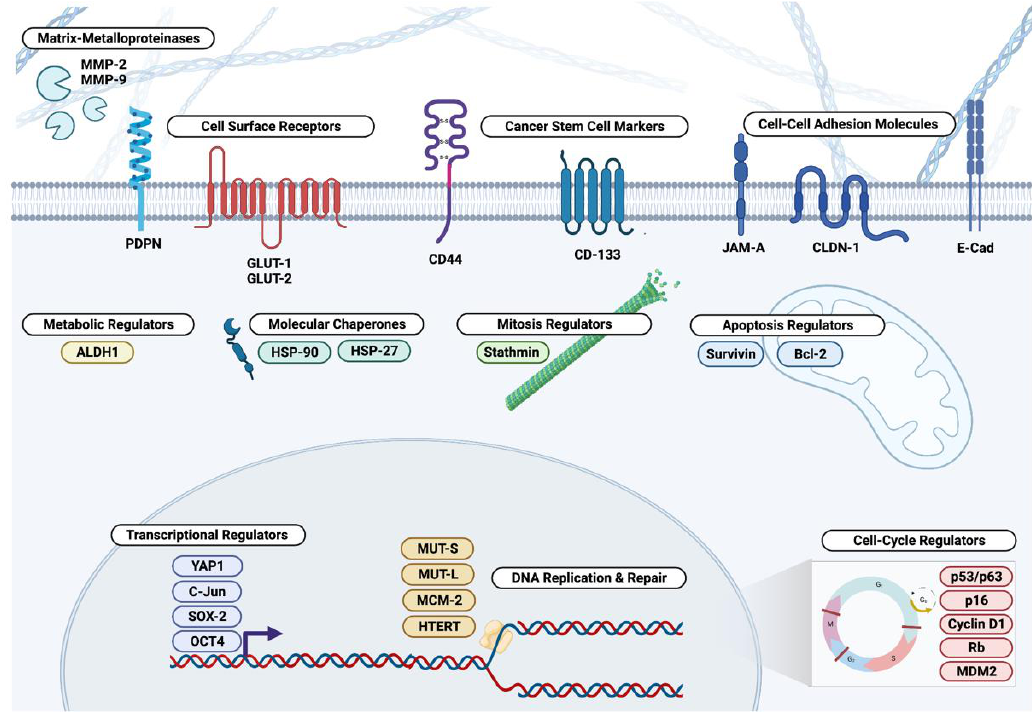
Figure 1. Molecular biomarkers in head and neck dysplasia. Biomarkers include matrix metallopro- teinases, cell surface receptors, cancer stem cell markers, cell adhesion molecules, transcriptional regulators, DNA replication and repair proteins, and cell cycle regulators. Created with BioRender.